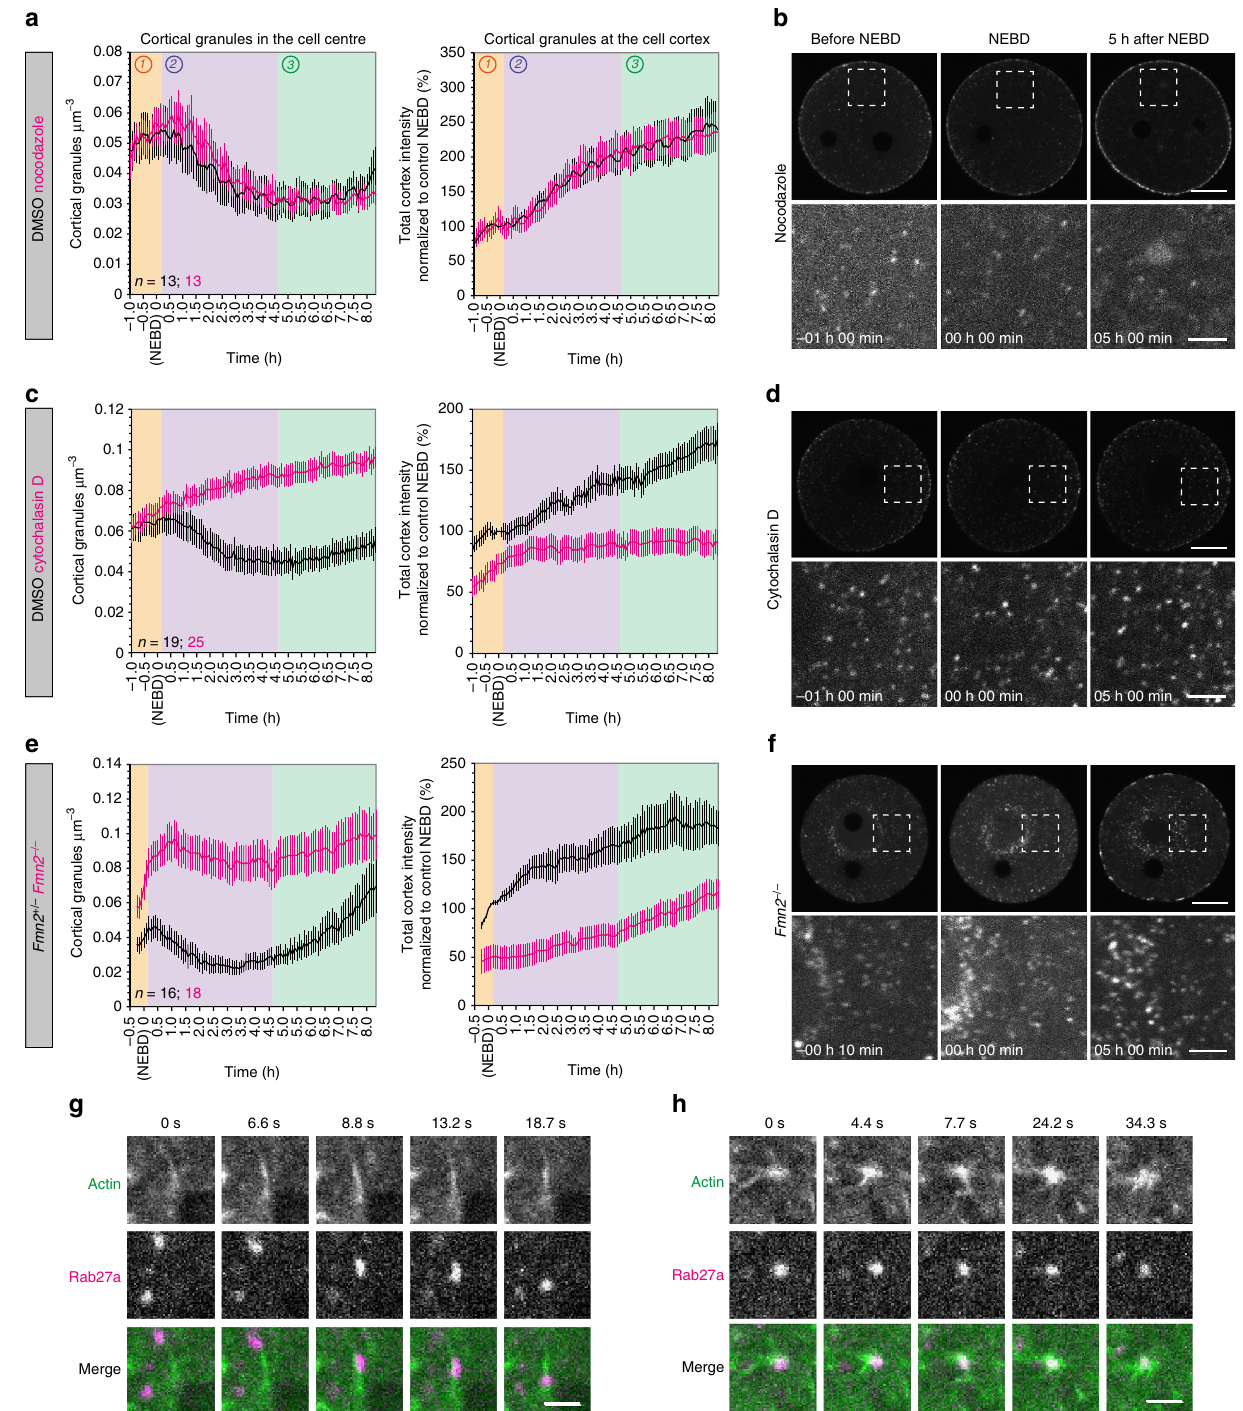
Figure 3 | Cortical granule translocation is dependent on the cytoplasmic actin network. Quantification of cortical granule translocation in the oocyte centre or cortex (mean ± s.e.m.) in cells treated with nocodazole or DMSO ( a ), cytochalasin D or DMSO ( c ), in Fmn2 (cid:2) / (cid:2) (which lack an important actin nucleator) or Fmn2 þ / (cid:2) oocytes ( e ). Representative still images (all maximum intensity projections of confocal Z sections) for each condition are presented in b , d and f . Control images are included in Supplementary Fig. 2. Scale bars, 20 m m (overview) and 5 m m (enlarged). ( g - h ) Still confocal images of a cortical granule being transported along actin ( g ), or interacting with an actin node ( h ). Scale bars, 2 m